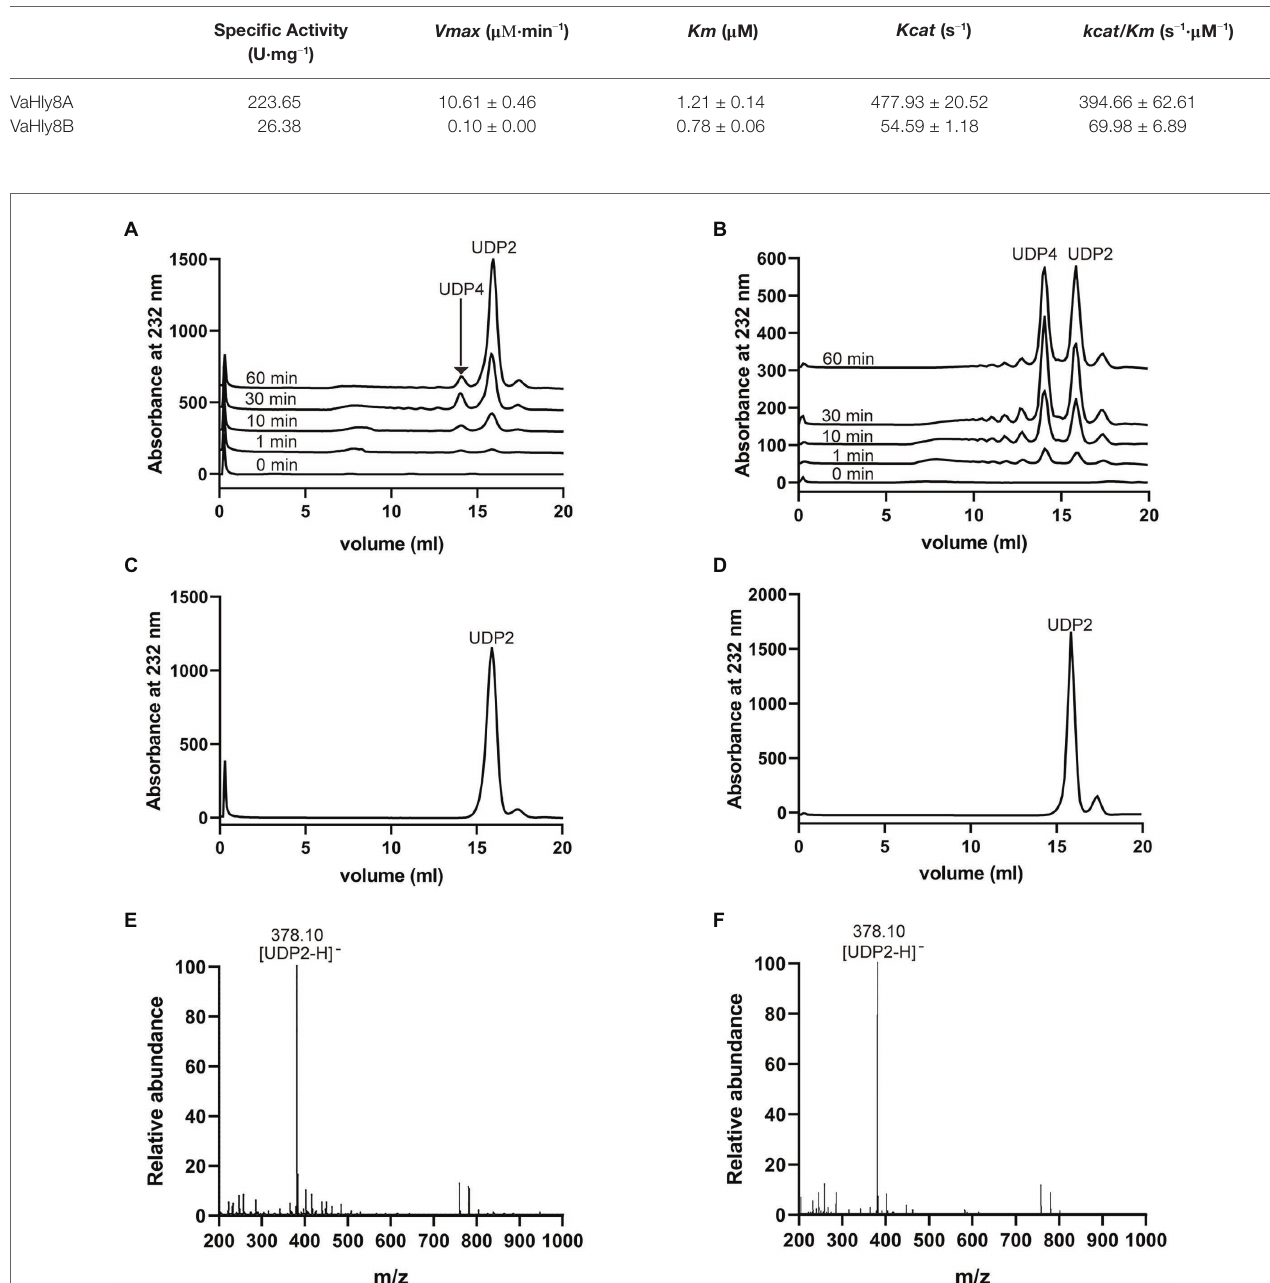
TABLE 1 | Specific activity and kinetic parameters of VaHly8A and